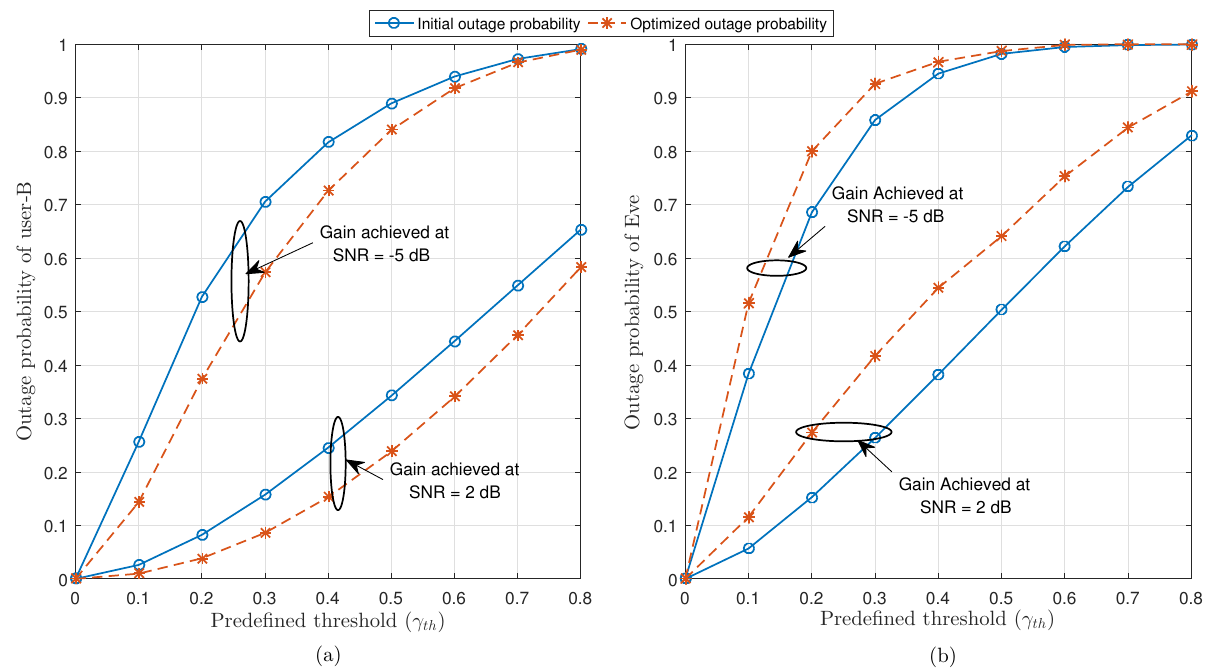
Proposed method with optimization (sim.) Proposed method with optimization (ana.) Transmit beamformer technique in [39] (sim.) Transmit beamformer technique in [39] (ana.) Proposed method without optimization with Eve. (sim.) Proposed method without optimization with Eve. (ana.)